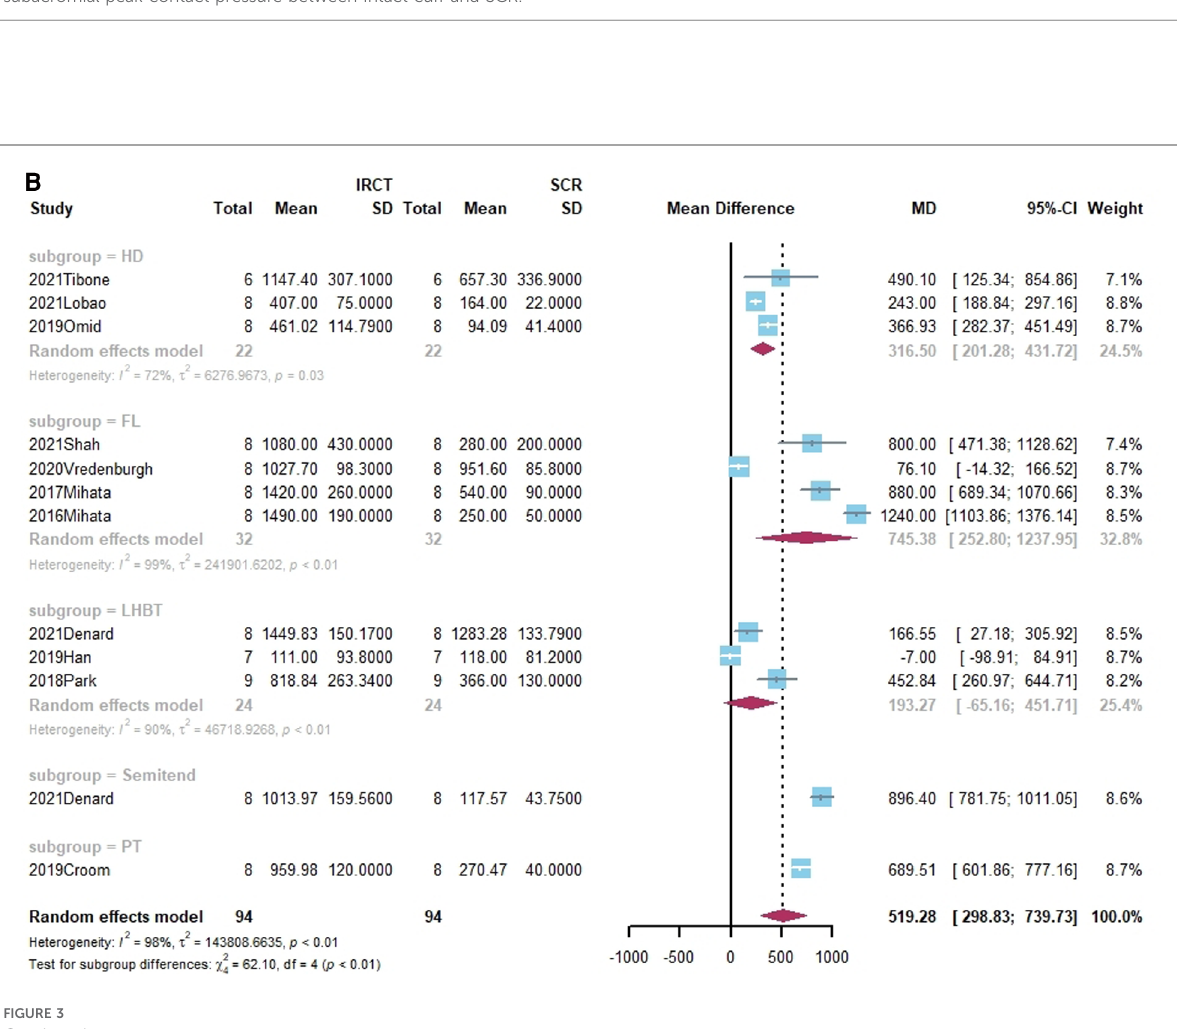
FIGURE 3 ( A ) Forest plot comparing the mean difference (MD) of subacromial peak contact pressure between Intact cuff and IRCT. ( B ) Forest plot comparing the mean difference (MD) of subacromial peak contact pressure between IRCT and SCR. ( C ) Forest plot comparing the mean difference (MD) of subacromial peak contact pressure between Intact cuff and